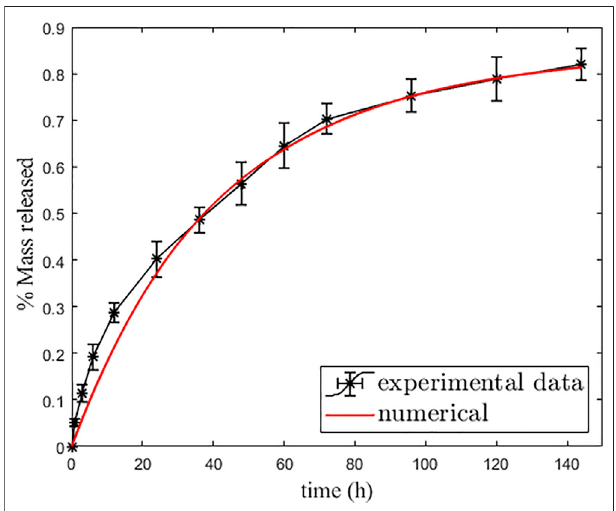
FIGURE 5 | Best fi t curve of simulation (red line) over experimental data (black line with error